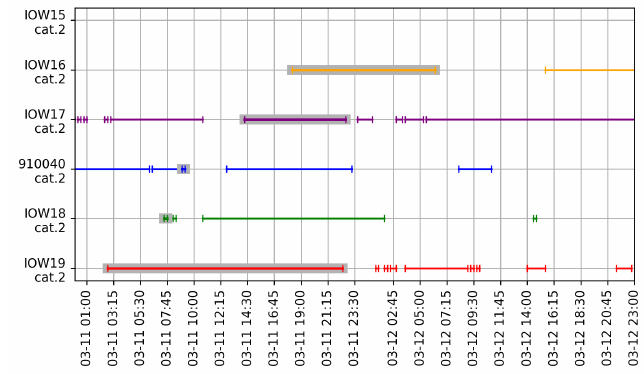
Figure 23. Flow Paths for Query